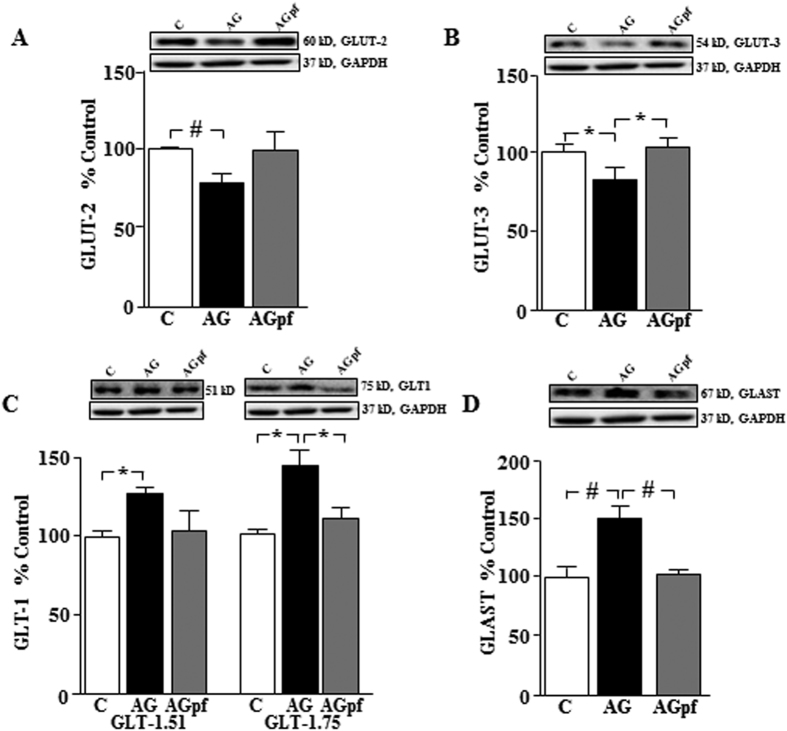
Analysis of glucose and glutamate transporters in response to chronic acyl-ghrelin treatment.Hypothalamic levels of (A) glucose transporter (GLUT)2, (B) GLUT3, (C) glial glutamate transporter 1 (GLT1) and (D) glutamate-aspartate transporter (GLAST) in male rats receiving acyl-ghrelin (AG) icv for 2 weeks (5 μg/day). Controls received saline and one group of AG treated rats were pair-fed (pf) with controls. *p < 0.05, #p < 0.01.